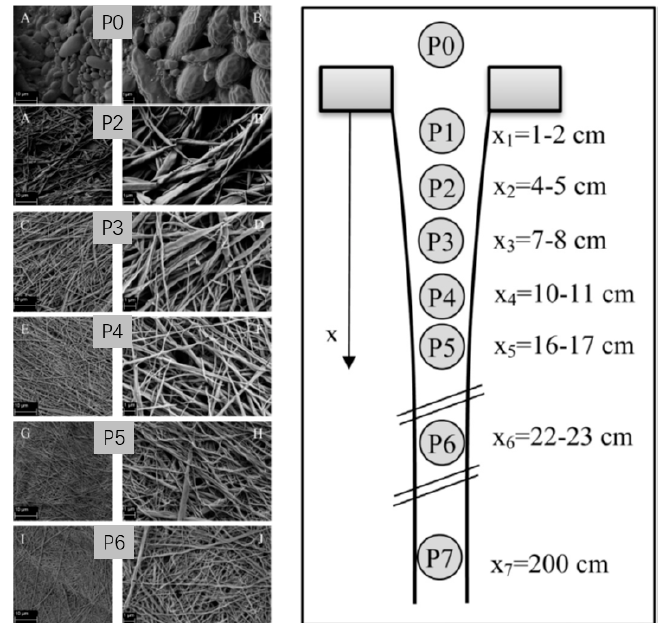
Figure 3. SEM images of poly (lactic acid) (PLA) domains at different spinning line positions according to the schematic view of the filament capturing diagram, which was shown on the right side of Figure 3: P0 (A and B), P2 (A and B), P3 (C and D), P4 (E and F), P5 (G and H), P6 (I and J) [32]. Reproduced with permission from Tran, N.H.A.; Brünig, H.; Boldt, R.; Heinrich, G., Polymer; published by Elsevier, 2014.